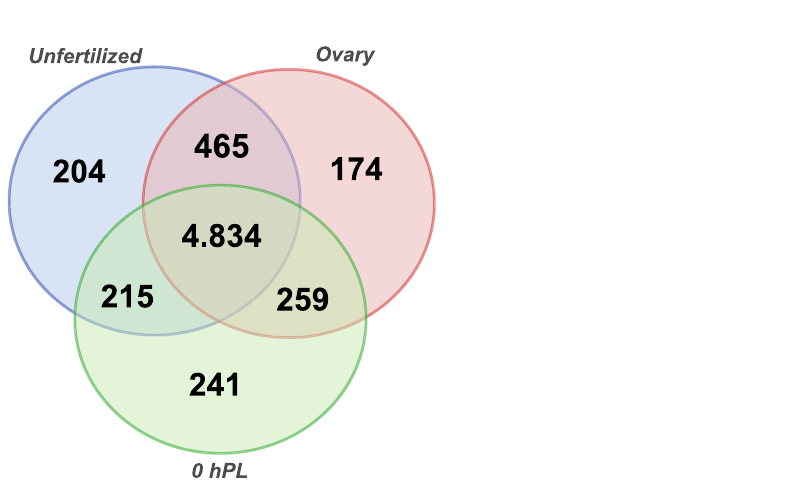
Figure 3. Venn diagram depicting the maternal transcripts across developmental stages. Comparison among the expressed transcripts of the Vitellogenic ovary, Unfertilized and 0 hPL , eggs and reference maternal